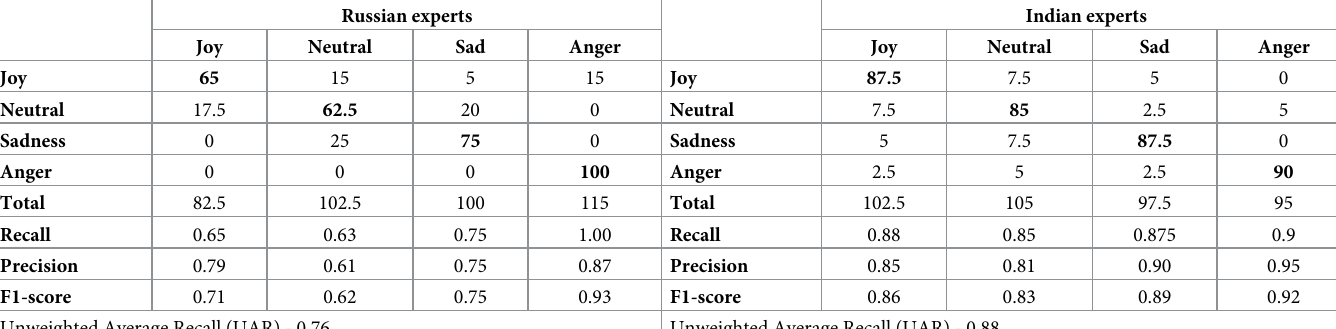
Table 9. Confusion matrix for emotion recognition in the emotional words & phrases of Tamil children by Russian and Indian experts. Russian experts